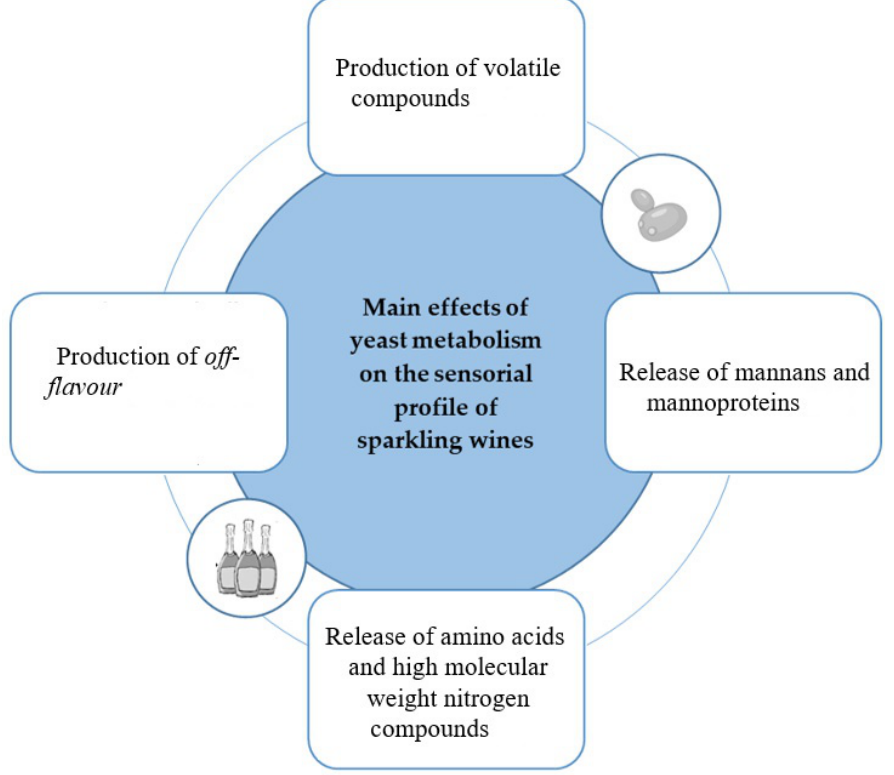
Figure 3. Impact of yeast metabolisms on the sensory properties of sparkling wines [1,25,34,40,41].